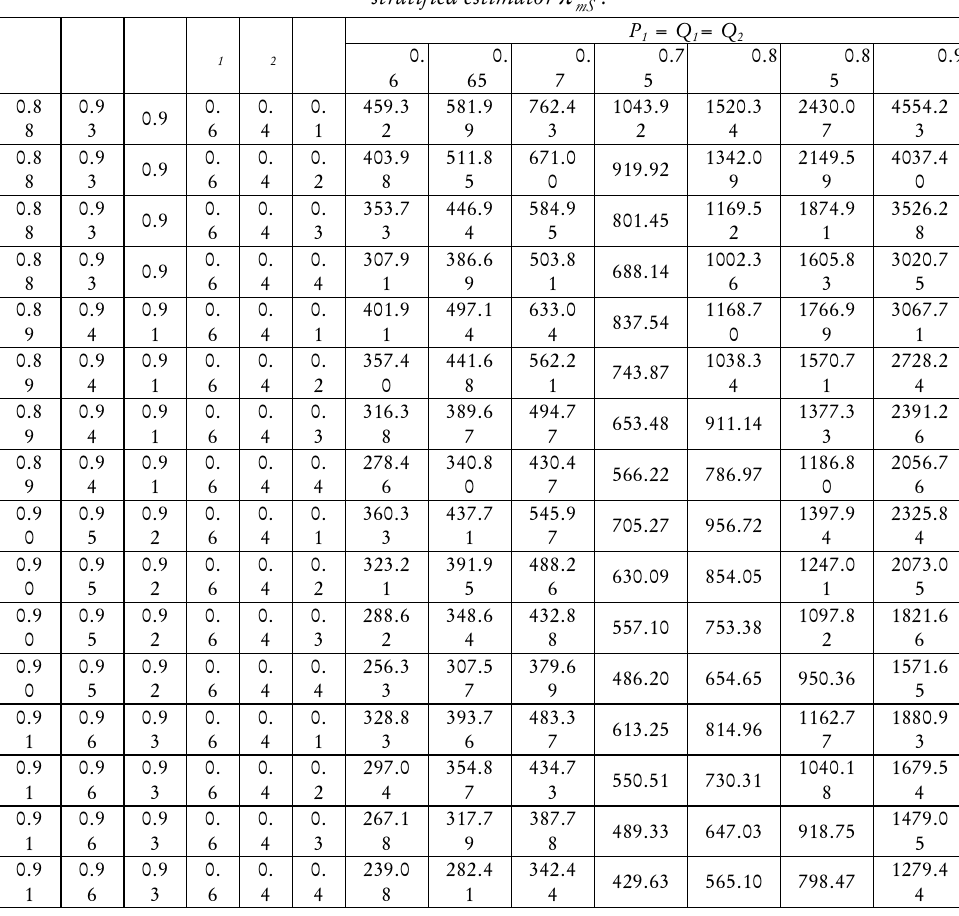
π with respect to the suggested mS π ∗ stratified estimator ˆ mS